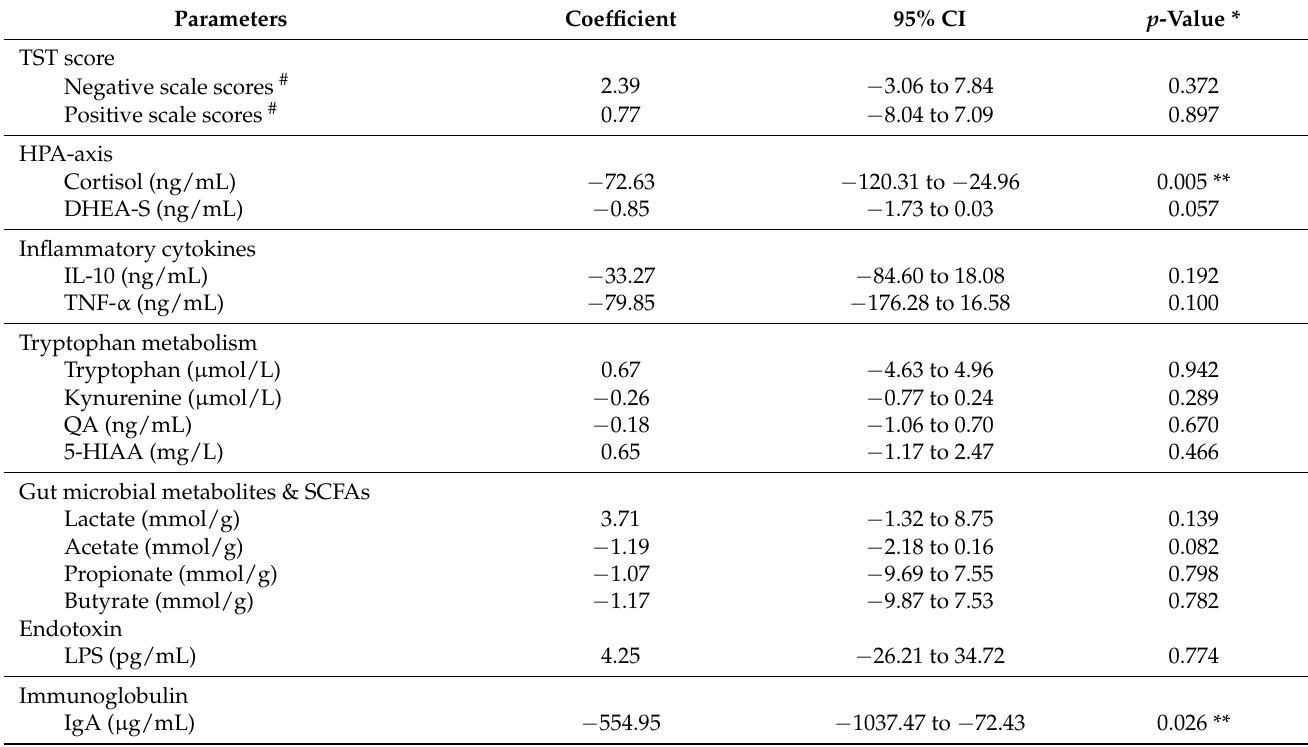
Table 4. Gaussian regression analysis of the outcomes after the 12th